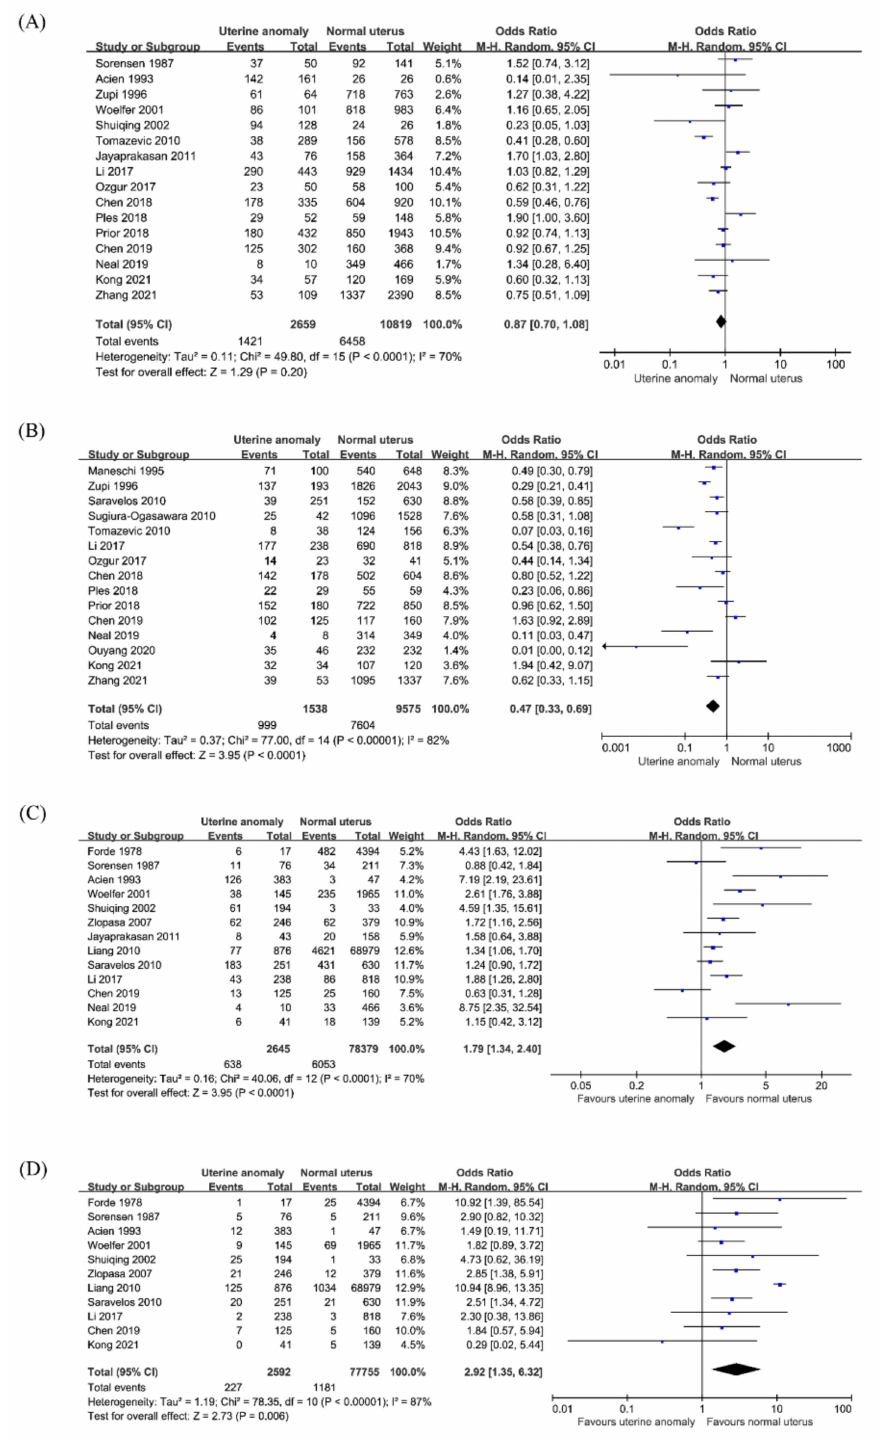
Figure 2. Reproductive outcomes in women with congenital uterine anomalies. ( A ) Clinical preg- nancy rate, ( B ) live birth, ( C ) first trimester miscarriage, ( D ) second trimester